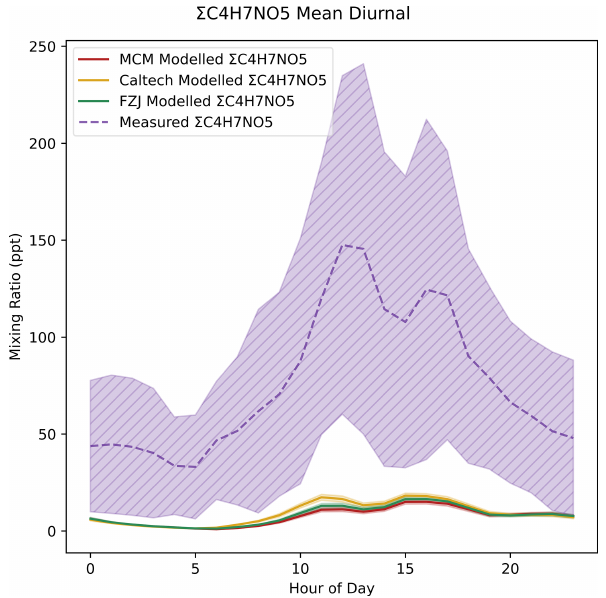
Figure 13. Measured and modelled (cid:54) C 4 H 7 NO 5 . Each line shows the mean value for each dataset, with the shaded area indicating 1 standard deviation above and below the